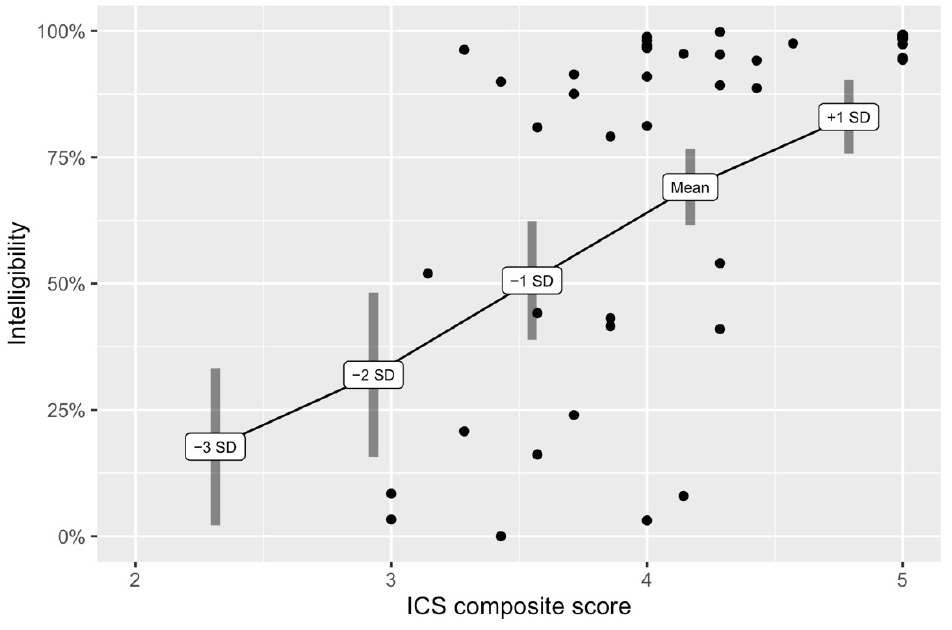
Figure 2. Predicted transcription intelligibility scores based on marginal ICS composite score mean with observed data points from participants.